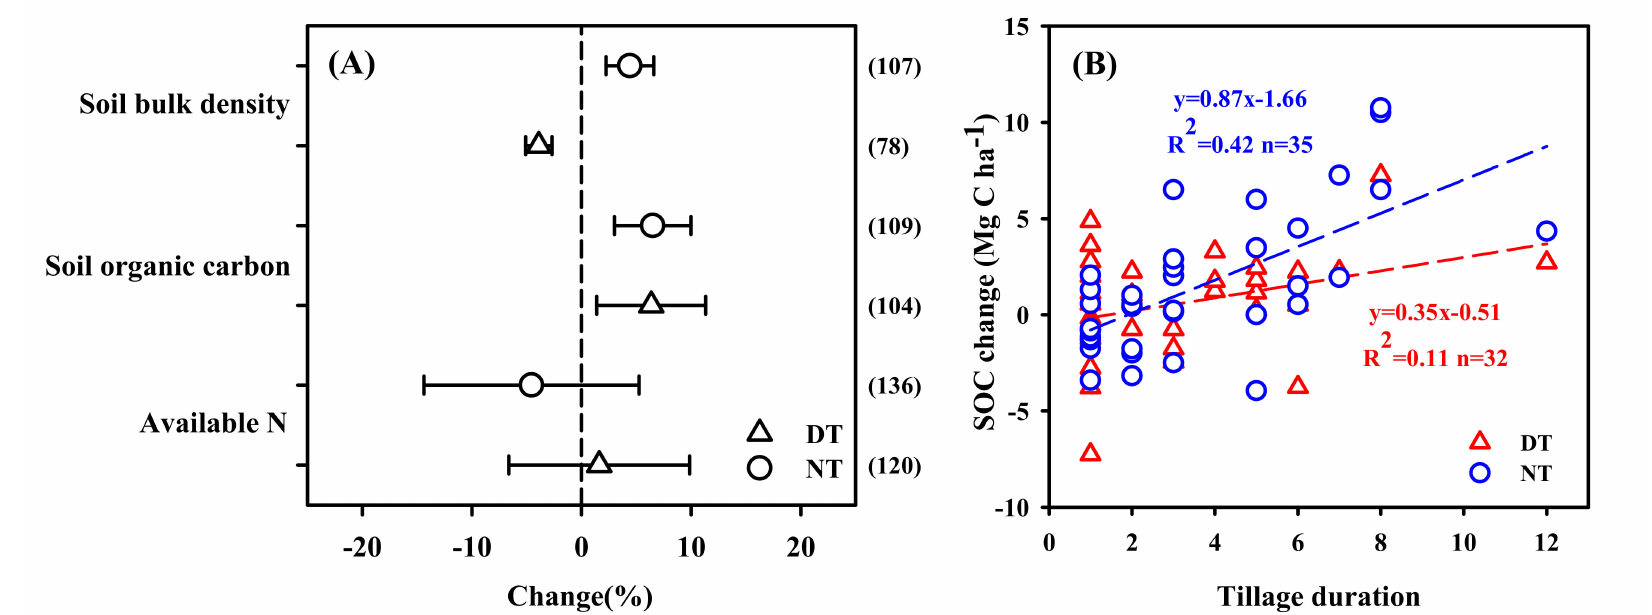
Figure 3. ( A ) Changes in soil properties under different tillage systems. Error bars represent 95% CIs. Triangles and circles indicate the effect size of DT and NT, respectively. The number of observations in each category is shown in parentheses. Differences are considered significant when the CIs do not include zero. ( B ) Linear relationships between tillage duration and SOC changes (Mg C ha − 1 ) under the DT and NT compared with RT management. Tillage duration was plotted against SOC changes for DT (triangles in red) and NT (circles in blue) in comparison with RT management. Red and blue dotted lines are the linear response for DT and NT, respectively. SOC, soil organic carbon; DT, deep tillage; NT, no tillage; RT, rotary